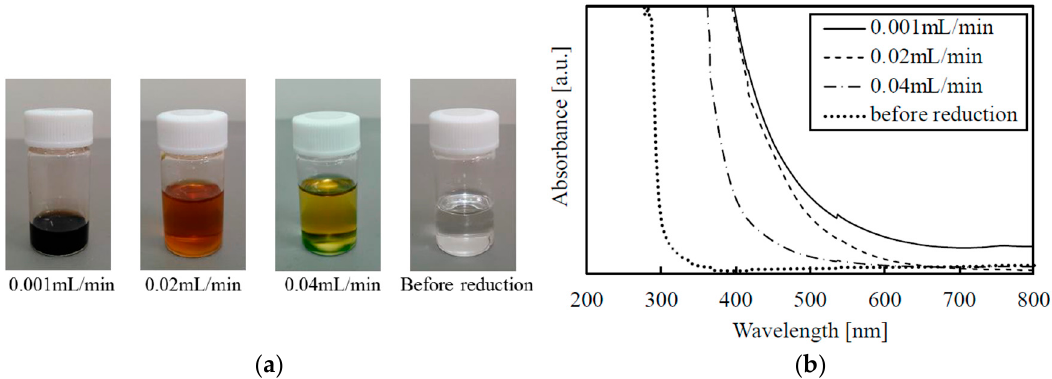
Figure 3. ( a ) Photograph of the CuNPs synthesized in the device at the temperature of 160 °C; ( b ) UV- visible spectra of the synthesized CuNPs and precursor solution (before reduction).